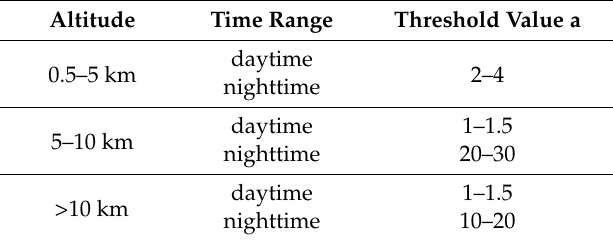
Figure 4. Case study using improved differential zero-crossing method [22]. Table 3. Tuning standard of threshold value in different altitude and time range.